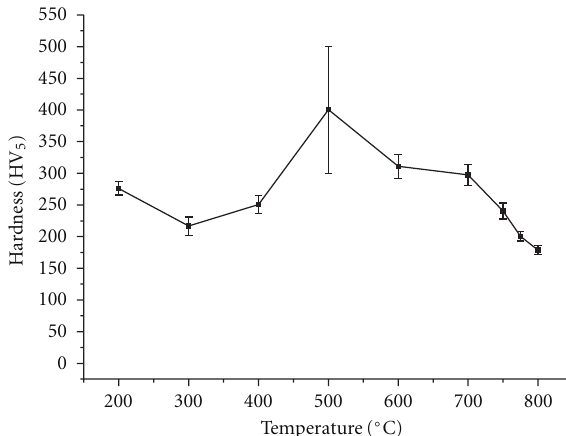
Figure 7: The high-temperature microhardness